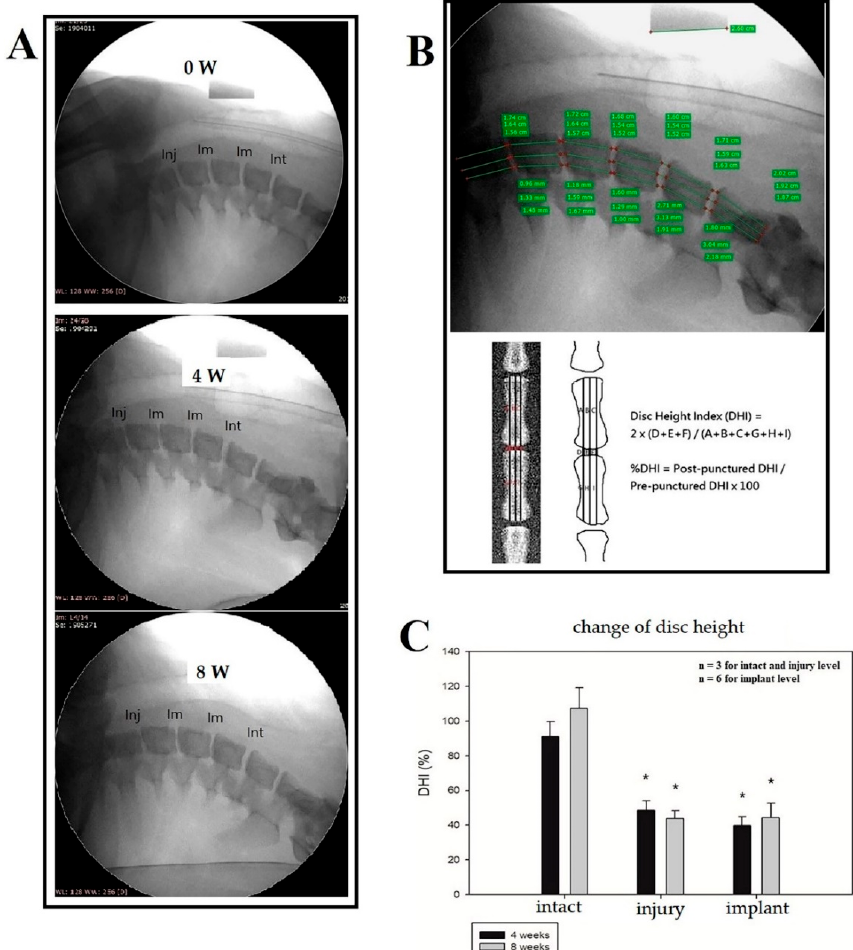
Figure 9. ( A ) Representative radiographs of the porcine cervical discs before, 4 weeks, and 8 weeks after the surgery (Int: intact; Im: implant; Inj: injury). ( B ) Demonstration of disc height measurement using image J software and definition of disc height index. ( C ) % DHI decreased significantly in both injury control and implant group, compared to those in intact control group at 4 weeks and 8 weeks. * p < 0.05 by t-test ( n = 3 for intact and injury group; n = 6 for implant group). The T2-weighted MR images are shown in Figure 10A. It was observed that the NP degenerated in both the injury control group and implant group compared to that of the control group. The T2-weighted MRI at 12 weeks showed a hyperintense foci that ap- peared in the AF annulotomy site of the injury control group, while a similar lesion was not found in all implant-repaired AF defects. This may be the high-intensity zone (HIZ), which is usually correlated to focal inflammation and neovascular ingrowth. HIZ is one such lumbar phenotype, which is reported as potential imaging biomarkers related to a